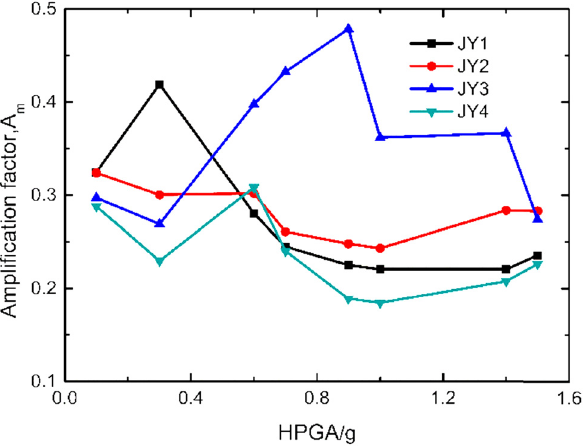
Figure 17: Ampli fi cation factor A m at J2, J4, J8, J10, and J12 against variable elevation.